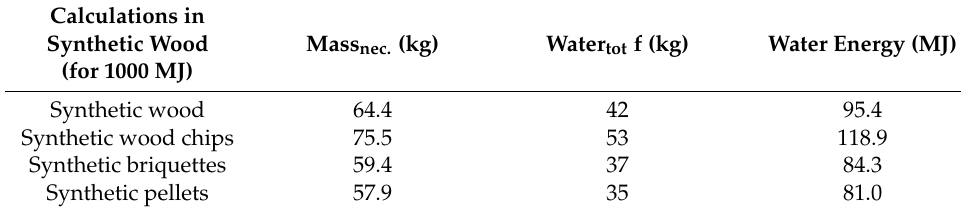
Table 8. Quantity of water and the energy that it represents. Calculations in Synthetic Wood